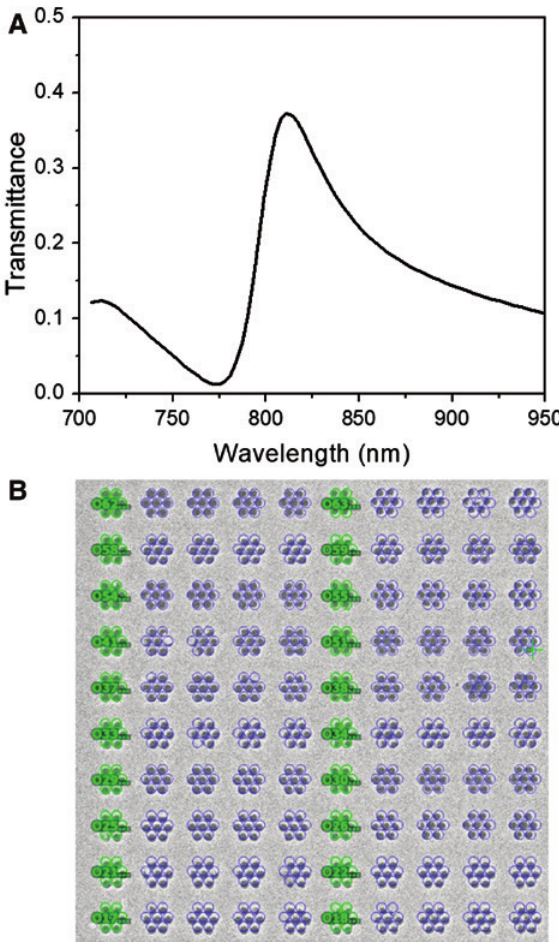
Figure 5: Theoretical calculation and drift correction failure. (A) Theoretical optical transmittance response of an HNH array. (B) HIM image overlapped with layout pattern, indicating drift correction